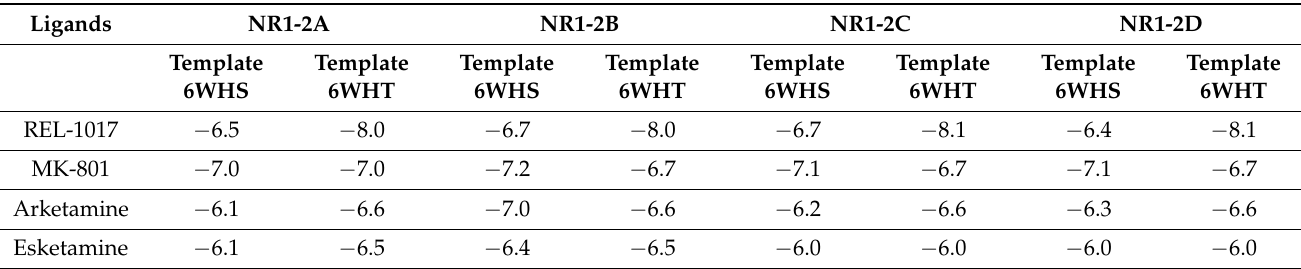
Table 7. Glide docking